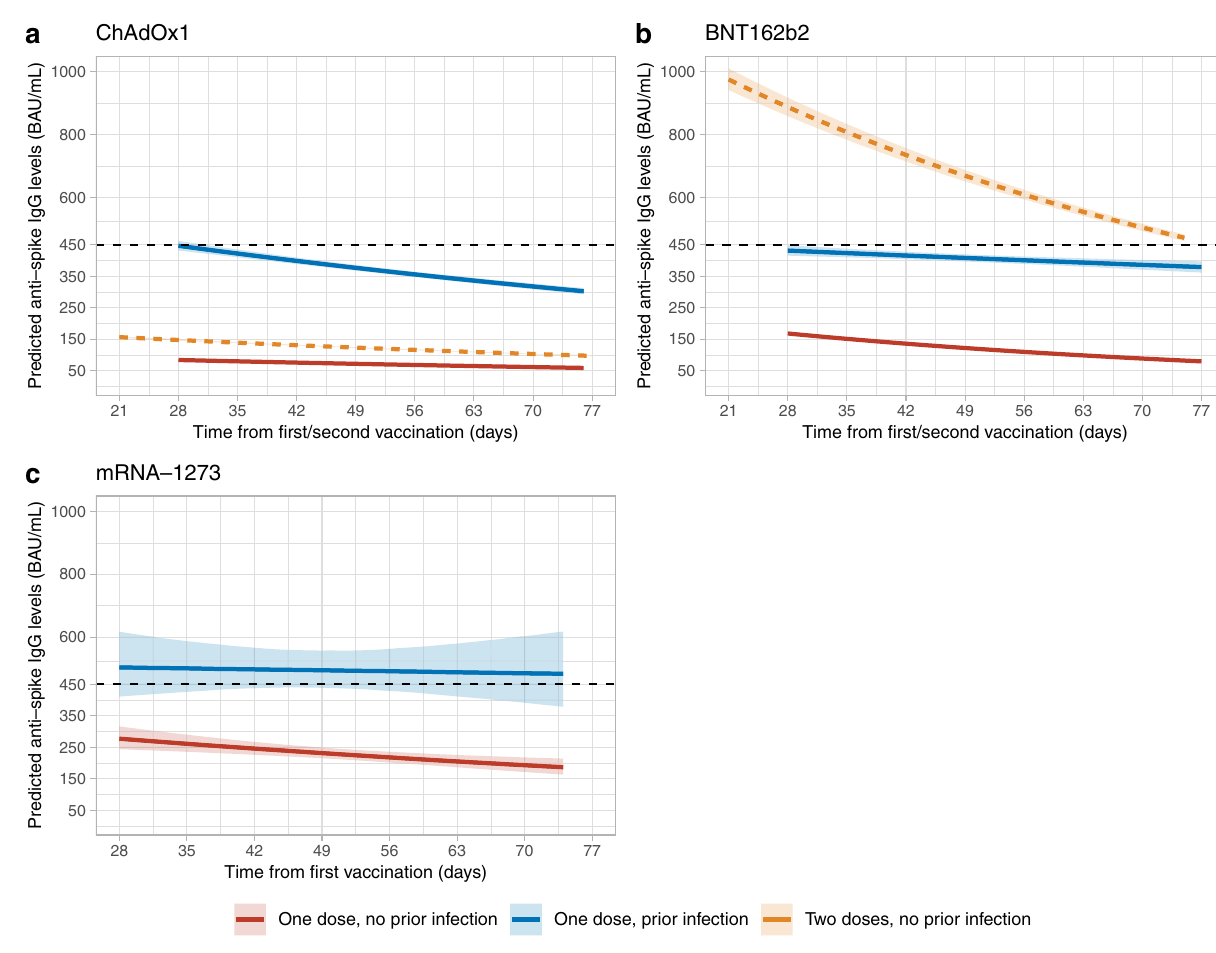
Fig. 1 Posterior predicted trajectories (95% credible interval) of anti-spike IgG levels from 28 days post- fi rst dose by prior infection status. a 59,101 participants who received at least a single ChAdOx1 vaccination. b 35,638 participants who received at least a single BNT162b2 vaccination. c 2597 participants who received at least a single mRNA-1273 vaccination. Plotted at reference categories: 50 years, female, white ethnicity, not reporting a long- term health condition, not a healthcare worker, and deprivation percentile = 60. Black dotted line shows the upper quanti fi cation limit of 450 BAU/mL. Orange dotted lines in panel a and b were predicted trajectories starting from 21 days post-second dose for 92,584 and 51,034 participants who received two ChAdOx1 and BNT162b2 vaccination without prior infection reproduced from our previous analysis, plotted at the same reference categories 16 . m1273- RNA was not included in this previous analysis due to insuf fi cient data at the